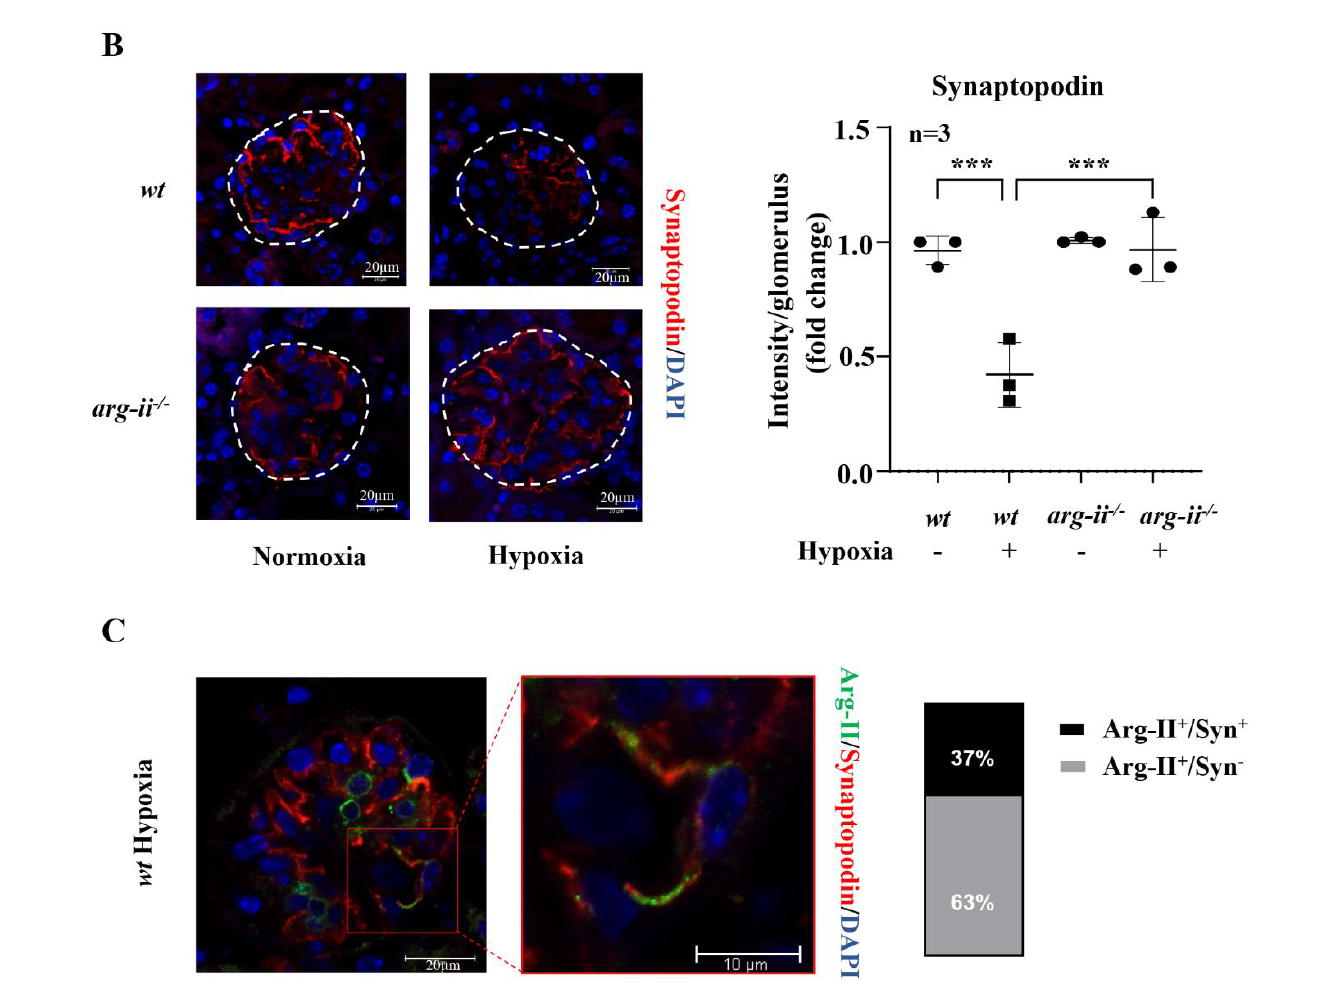
Figure 6. Arg-ii ablation prevents hypoxia-induced synaptopodin reduction in glomeruli ex vivo. Confocal immunofluorescence staining of ( A ) Arg-II, ( B ) synaptopodin and ( C ) co-localization of Arg-II (green) and synaptopodin (red) with quantification of Arg-II + /synaptopodin + and Arg- II + /synaptopodin - signals in isolated kidneys from wt and arg-ii −/− mice that were exposed to normoxia or hypoxia conditions (1% O 2 , 24 h) ex vivo. Nucleoli were stained with DAPI (blue). n = 3, * p < 0.05, *** p < 0.001 between the indicated